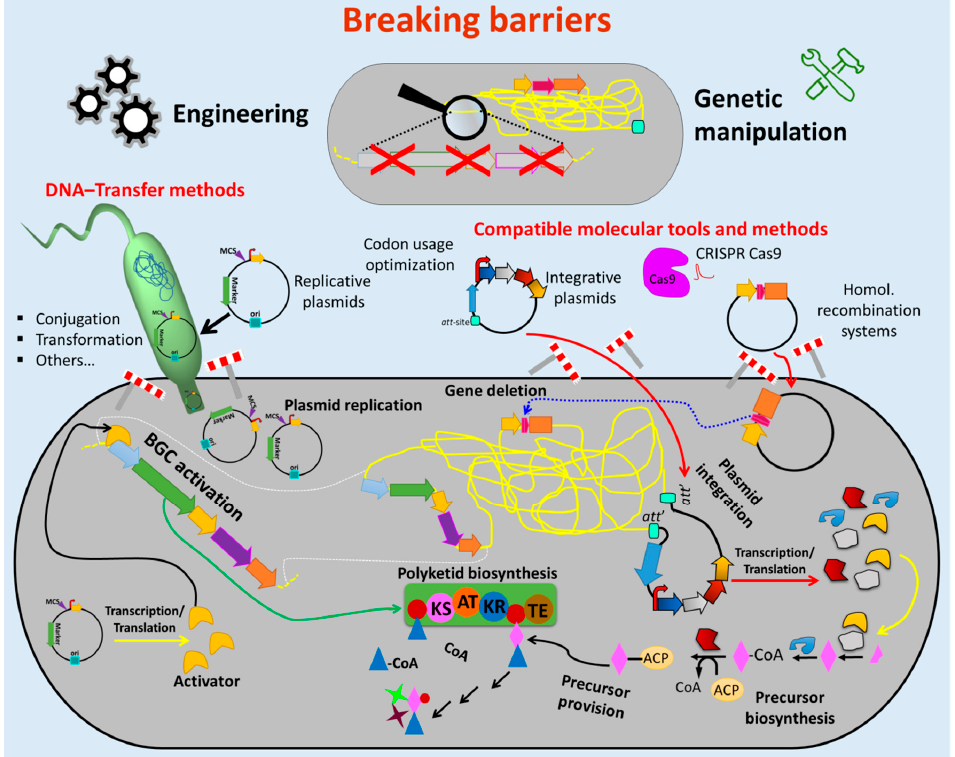
Figure 2. Breaking down the barriers to genetic manipulation and engineering of actinomycetes. Numerous methods and tools were developed to facilitate the genetic manipulation of